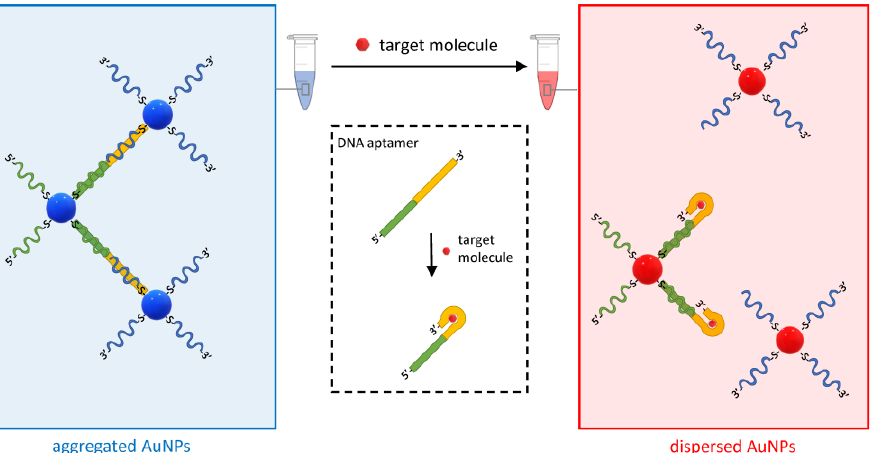
Figure 9. Schematic of the working principle of the aptamer-based plasmonic assay. The method uses DNA aptamers hybridized to DNA oligos on two sets of AuNPs. The aptamer undergoes a conformational change when bound to the analyte, which causes the de-hybridization of one of the complementary DNA oligos and the subsequent dispersion of the AuNPs.